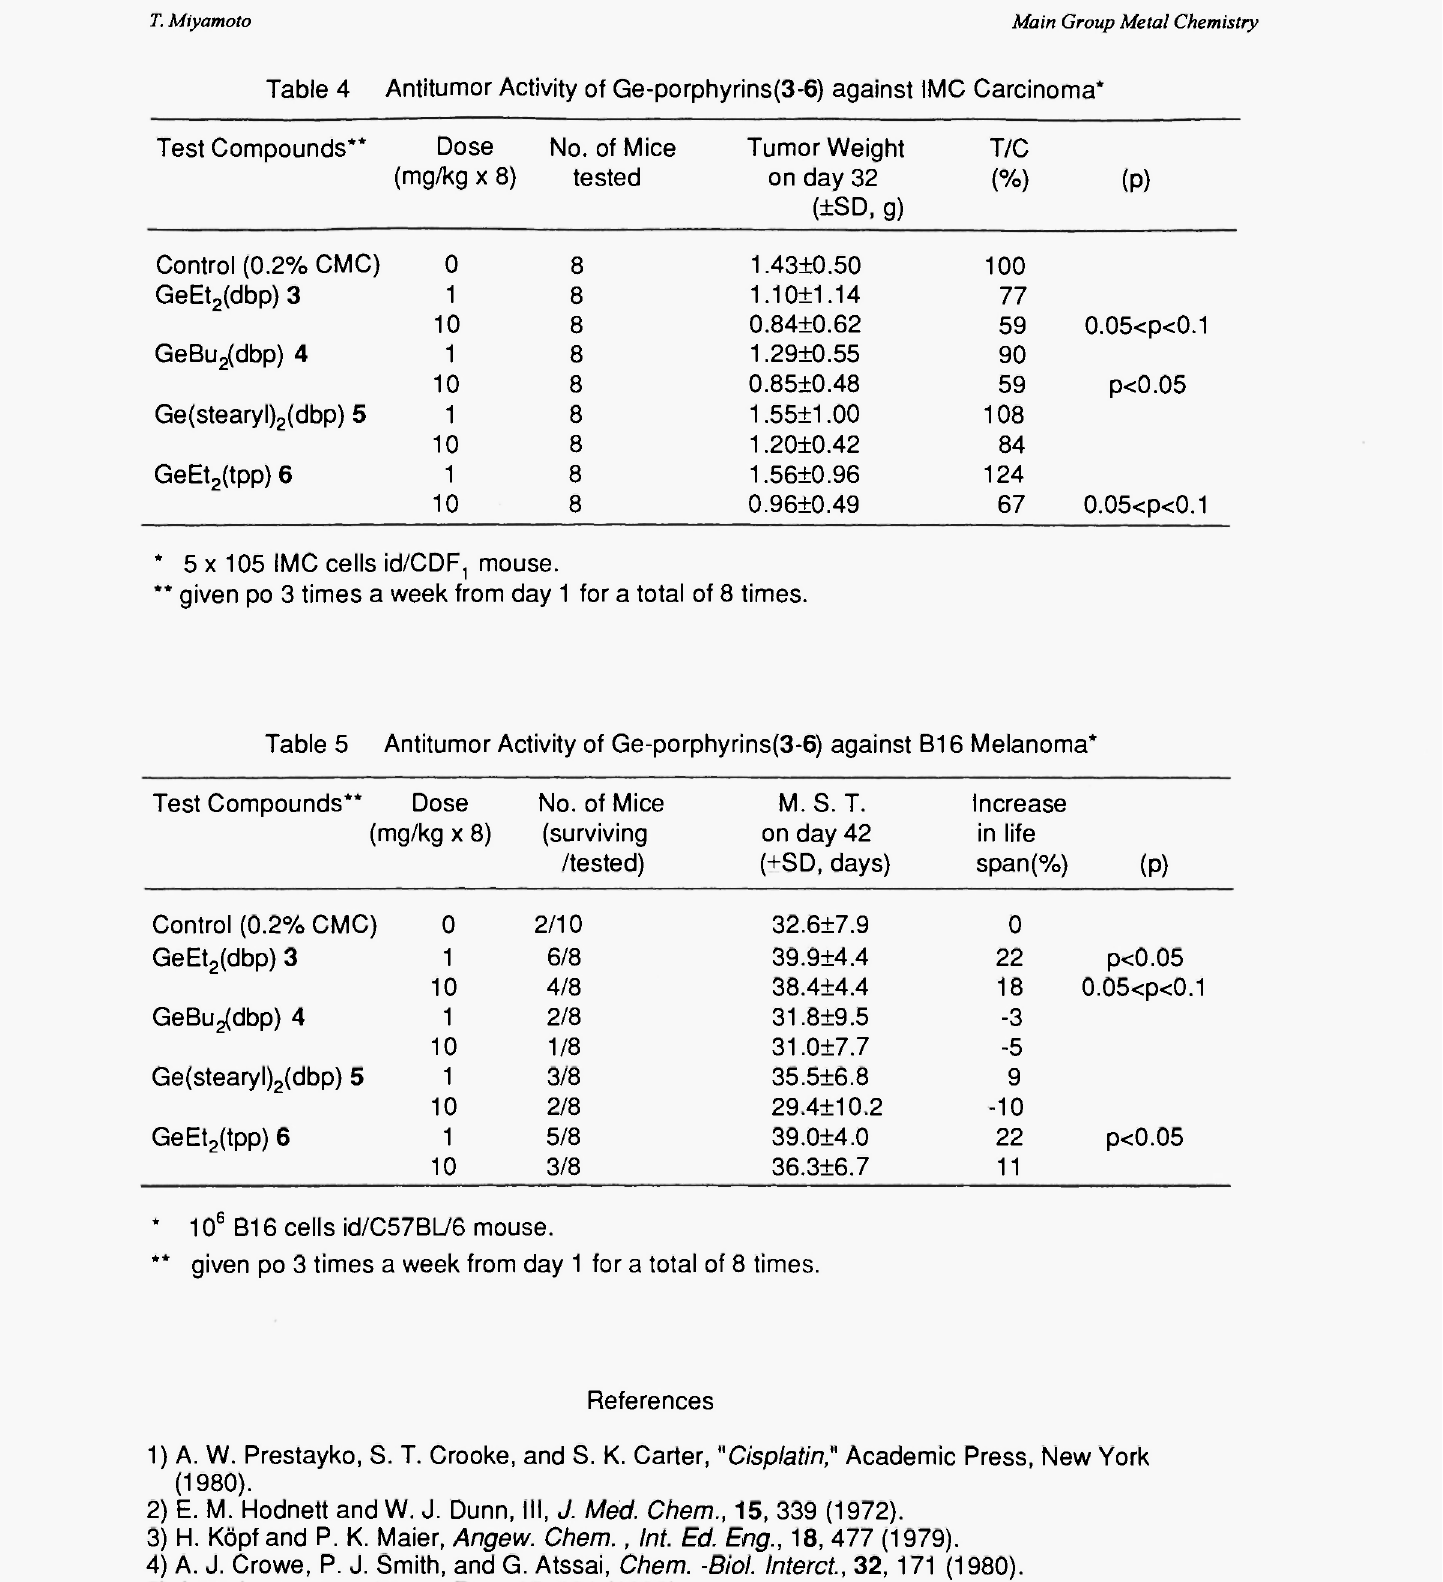
, Antitumor Activity of Ge-porphyrins(3-6) against IMC Carcinoma* Test Compounds**